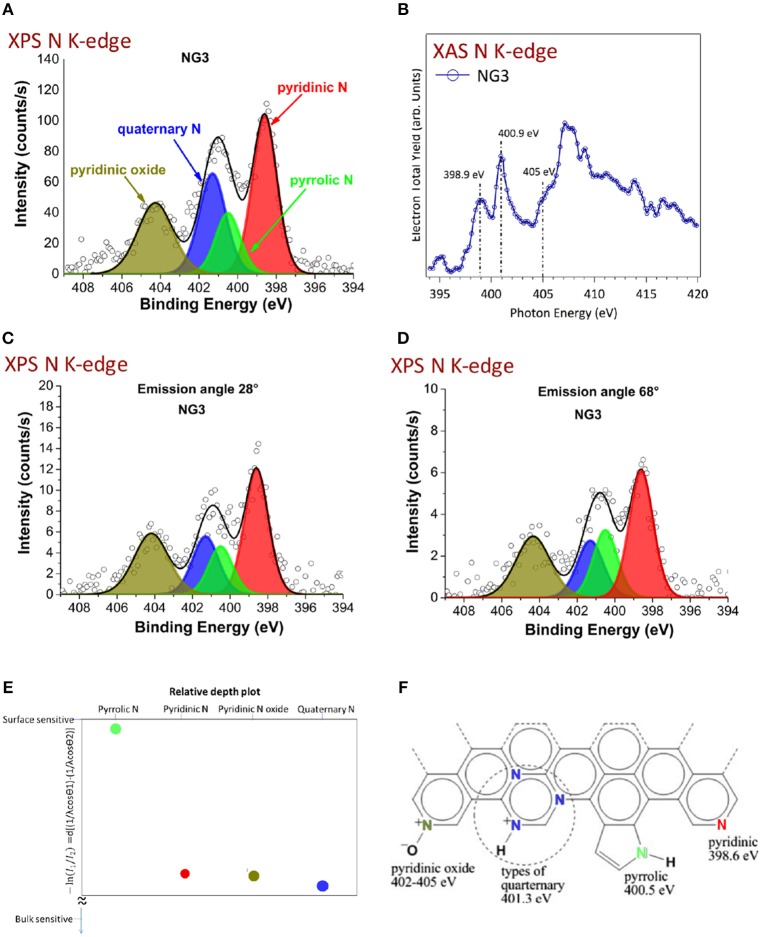
Chemical investigation of the nitrogen chemistry of the graphene layers. (A) XPS N K-edge of N-doped graphene (2.4%N); (B) XAS N K-edge of N-doped graphene; (C,D) ARXPS N K-edge of the N-doped graphene with an emission angle of 28 and 68°; (E) Ratio of intensity I1 (from ARXPS with 68°) to intensity I2 (from ARXPS with 28°) for each of the four nitrogen chemical contributions deduced from XPS, giving rise to a surface predominance of the pyrrolic from (green signal); (F) molecular scheme of the various N chemical forms identified by XPS and XAS in a N-doped graphene monolayer [Reproduced from Maddi et al. (2018) with permission of Nature Publishing Group].